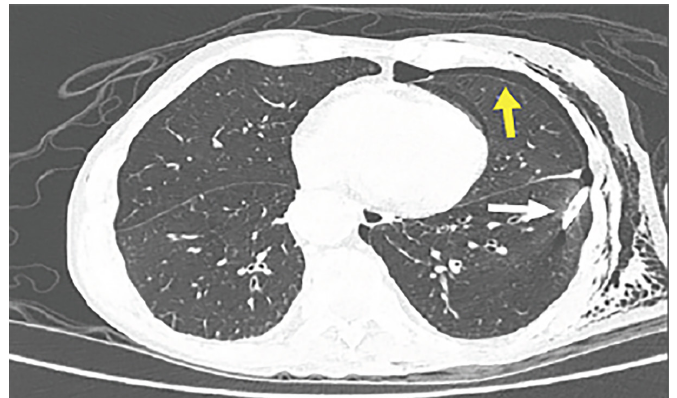
Image 2. Chest computerized tomography: pigtail within the lung parenchyma (white arrow) and a residual pneumothorax (yellow